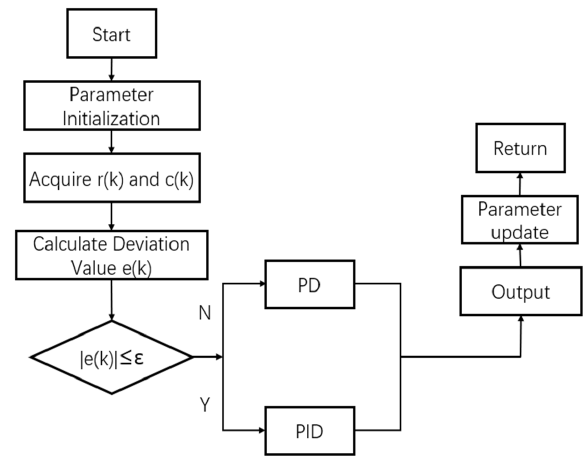
Figure 4. Integral separation PID flow chart.